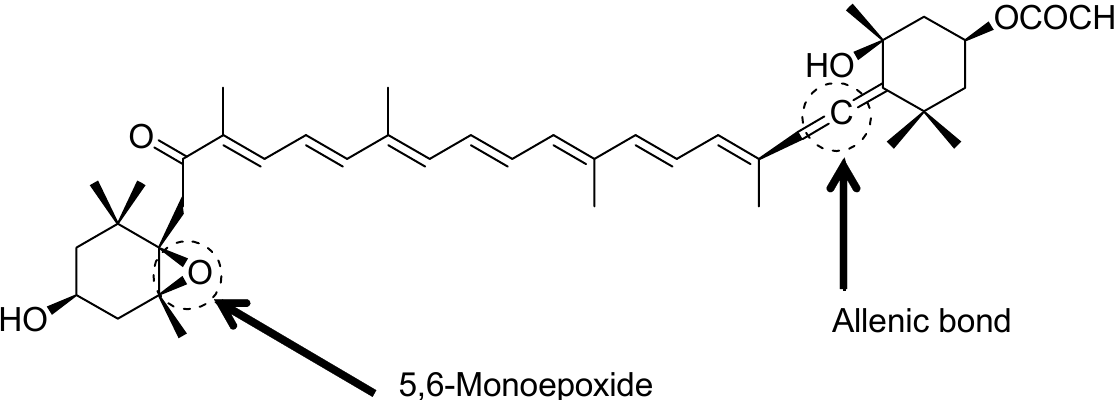
Figure 2. Chemical structure of fucoxanthin.